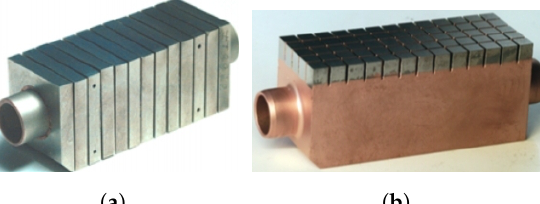
Figure 5. Prototypes of W designs as PFC for ITER. ( a ) Monoblock design. ( b ) Flat tile design. Reprinted from Ref.